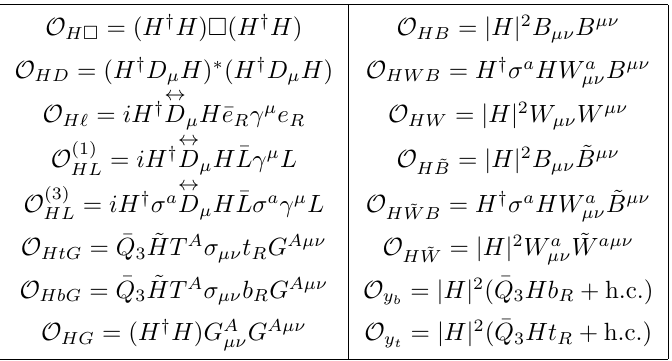
Table 1 . List of dimension-six operators in the Warsaw basis which contribute to the anomalous hV V ∗ /hV ¯ ff , the effective Higgs-gluon, Yukawa and chromomagnetic couplings in eq. (2.1). Details about the notations can be found in ref.